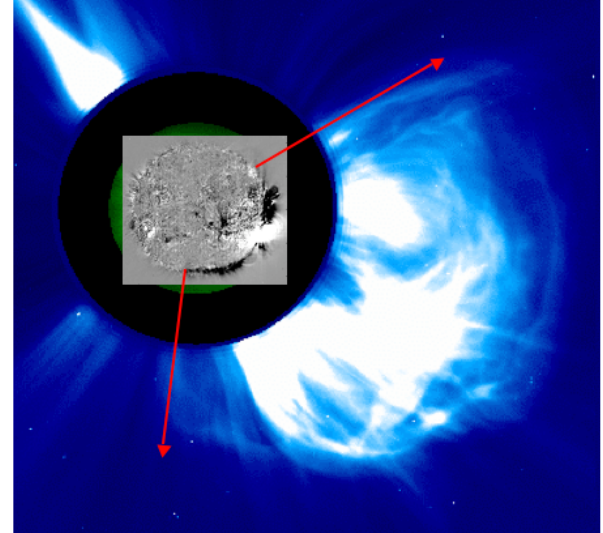
Fig. 2. CME on the 4 November 2003 (EIT and LASCO/C2: same times as in Fig. 1). Showing how the spatial extent of dimming in the low corona approximately matches the angular width of the CME. The SOHO/EIT image is a base difference image, i.e. a pre- event image was subtracted from